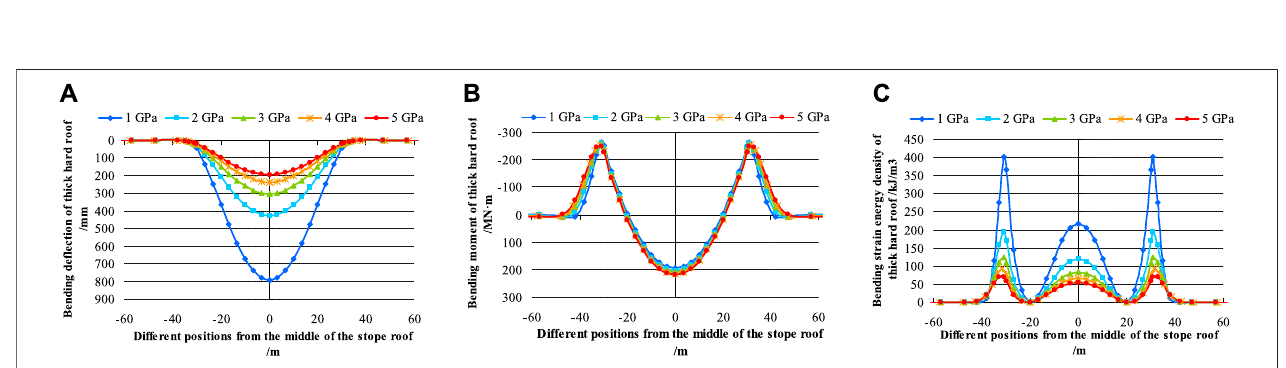
FIGURE 7 | Mechanical in fl uence characteristics of the rock stratum elastic modulus on the mining bearing capacity of the thick hard roof (A) Distribution characteristics of bending de fl ection. (B) Distribution characteristics of stressed bending moment. (C) Distribution characteristics of elastic energy accumulation.